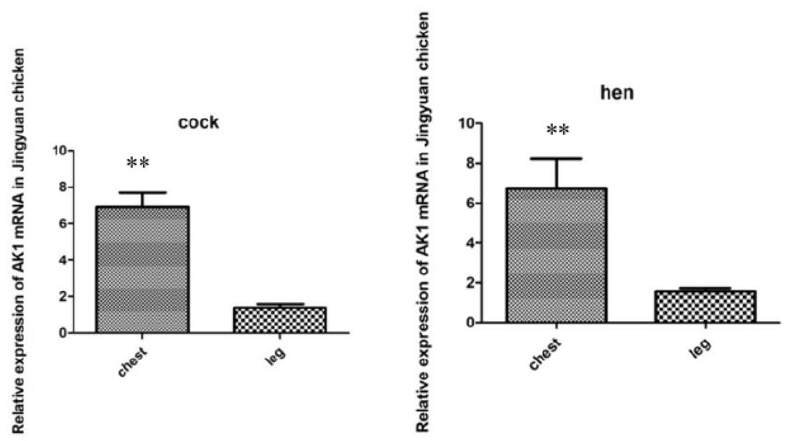
Figure 7. Comparison of AK1 mRNA expression levels in the breast and leg muscles of cock and hen of Jingyuan chickens. ** represents significant difference in expression of AK1 in chest and leg muscles